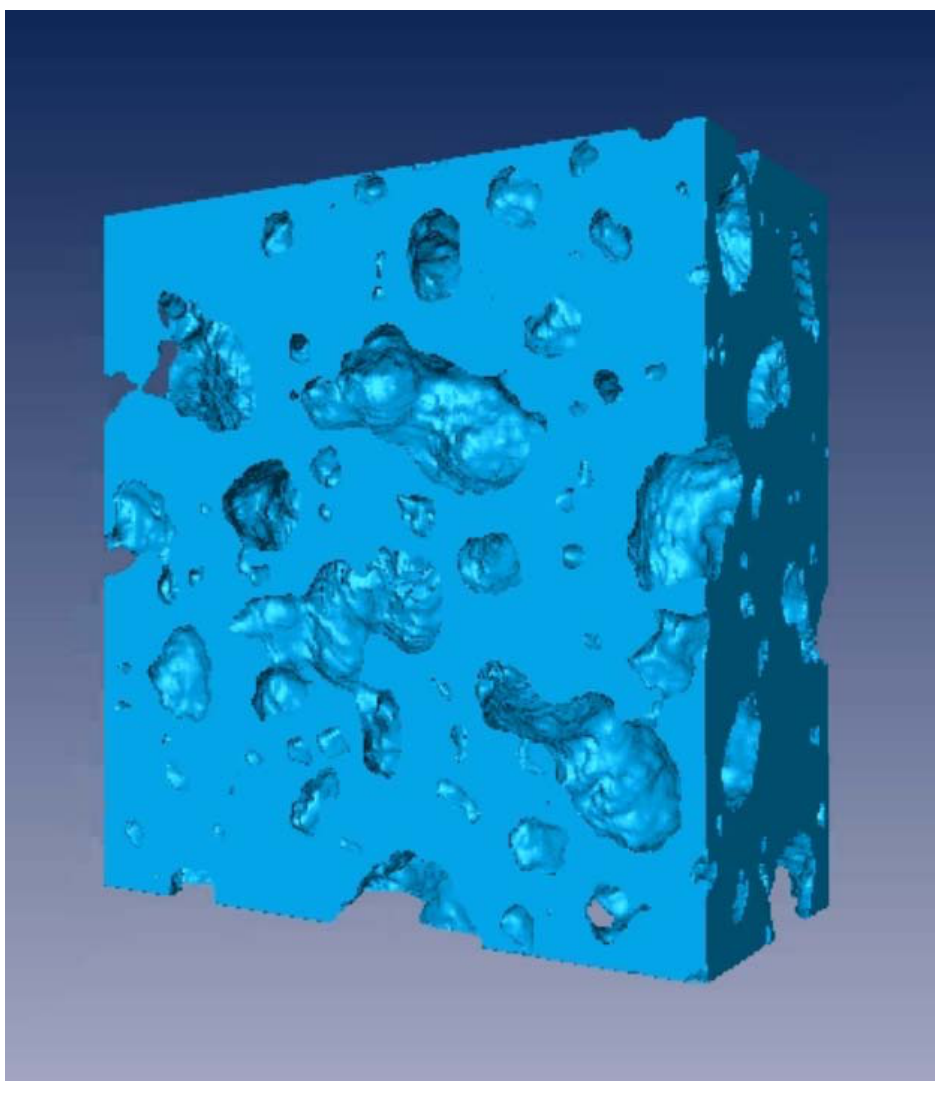
Figure 6. Rendered view of reconstructed PCX tomography data for a small (maximum side length ~1 cm) sample of HySSIL light-weight, high-strength concrete: 60 kVp, 25 μ A; source-to-sample distance = 31 cm; sample-to-detector distance = 19